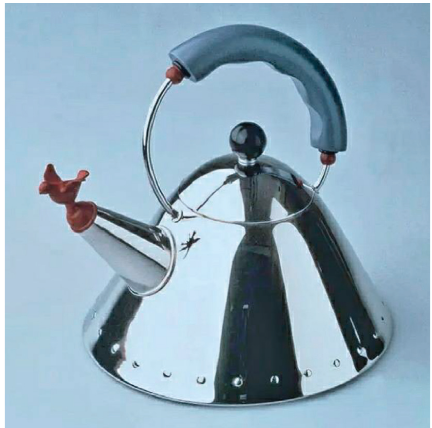
Figure 3: Design artwork